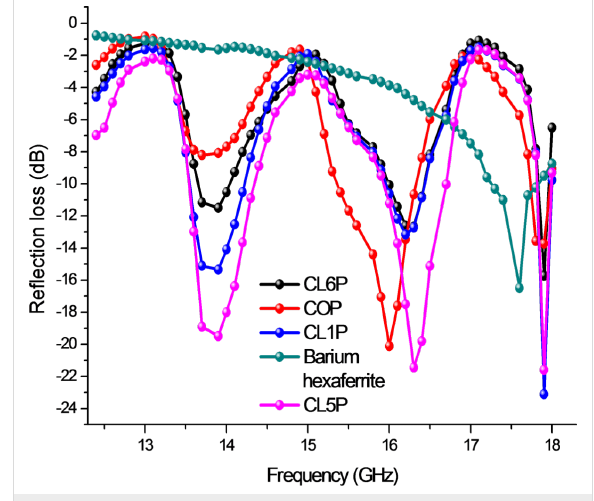
Figure 6: Reflection loss for